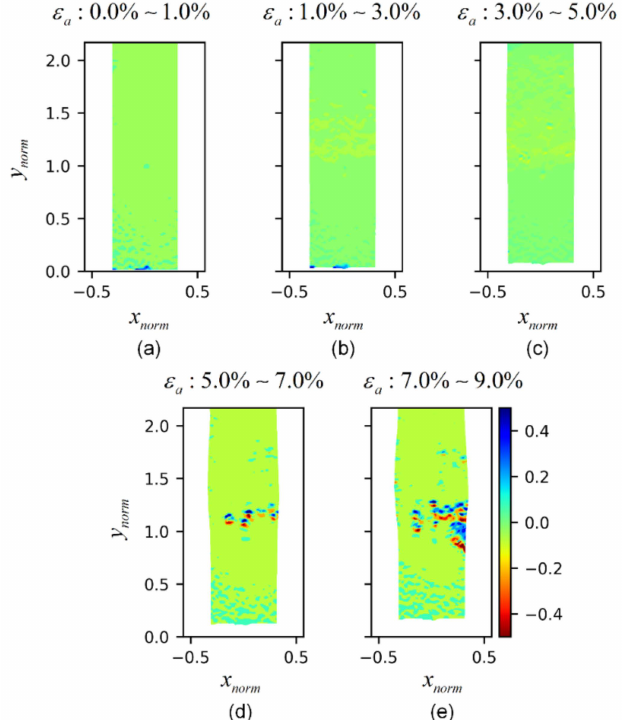
Figure 29. Evolution of gradient along ˆ y axis F 33 of test 120704c: ( a ) axial strain 0.0%–1.0%; ( b ) axial strain 1.0%–3.0%; ( c ) axial strain 3.0%–5.0%; ( d ) axial strain 5.0%–7.0%; ( e ) axial strain